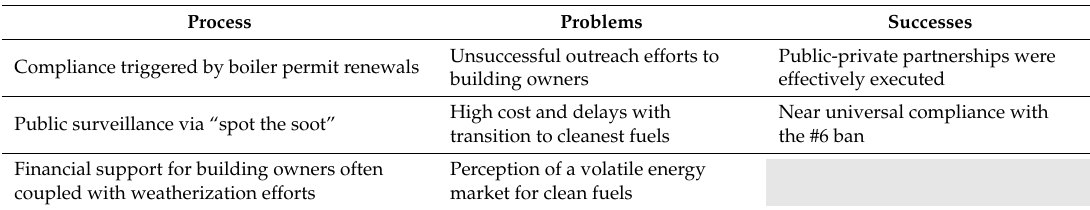
Table 4. Main qualitative